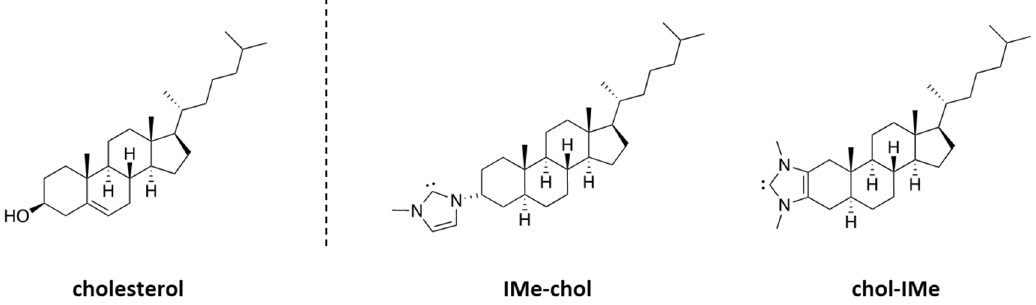
Figure 21. Cholesterol ( left ) and NHC ligands derived from cholesterol ( right ) used for Ru NP stabilization. Adapted from reference 99. Copyright 2018 The Royal Society of Chemistry.